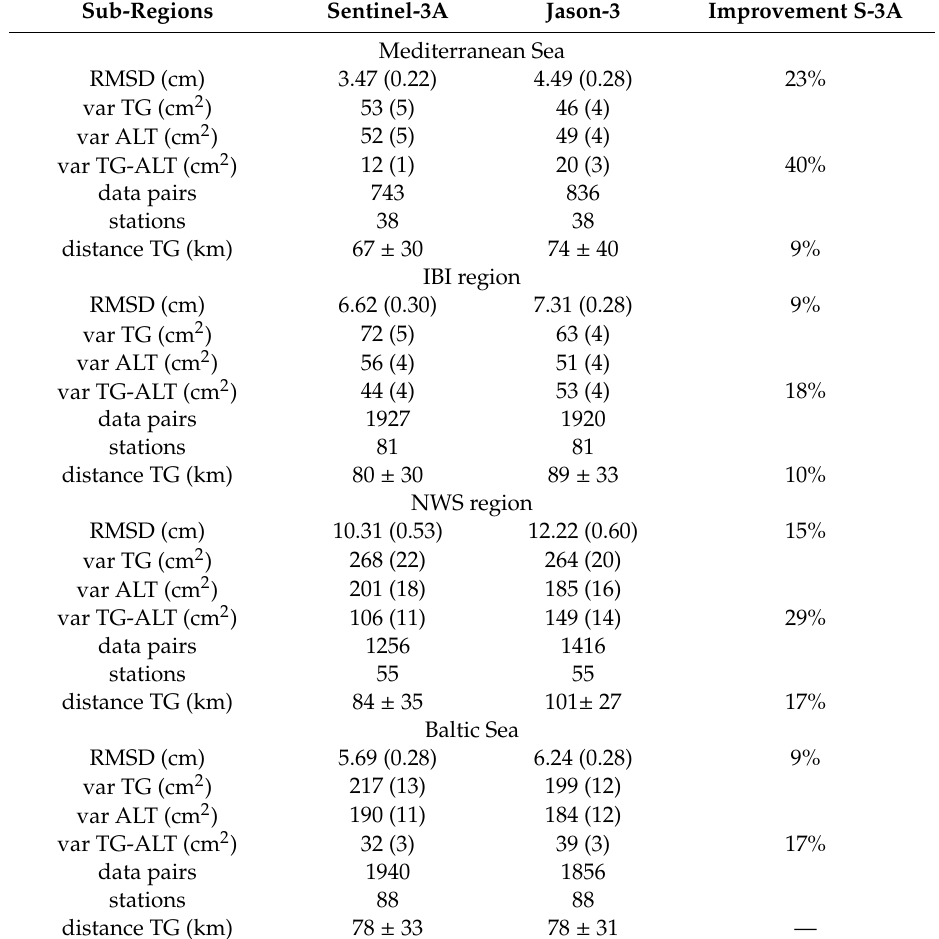
Table 2. The same as Table 1 but for the di ff erent sub-regions investigated: Mediterranean